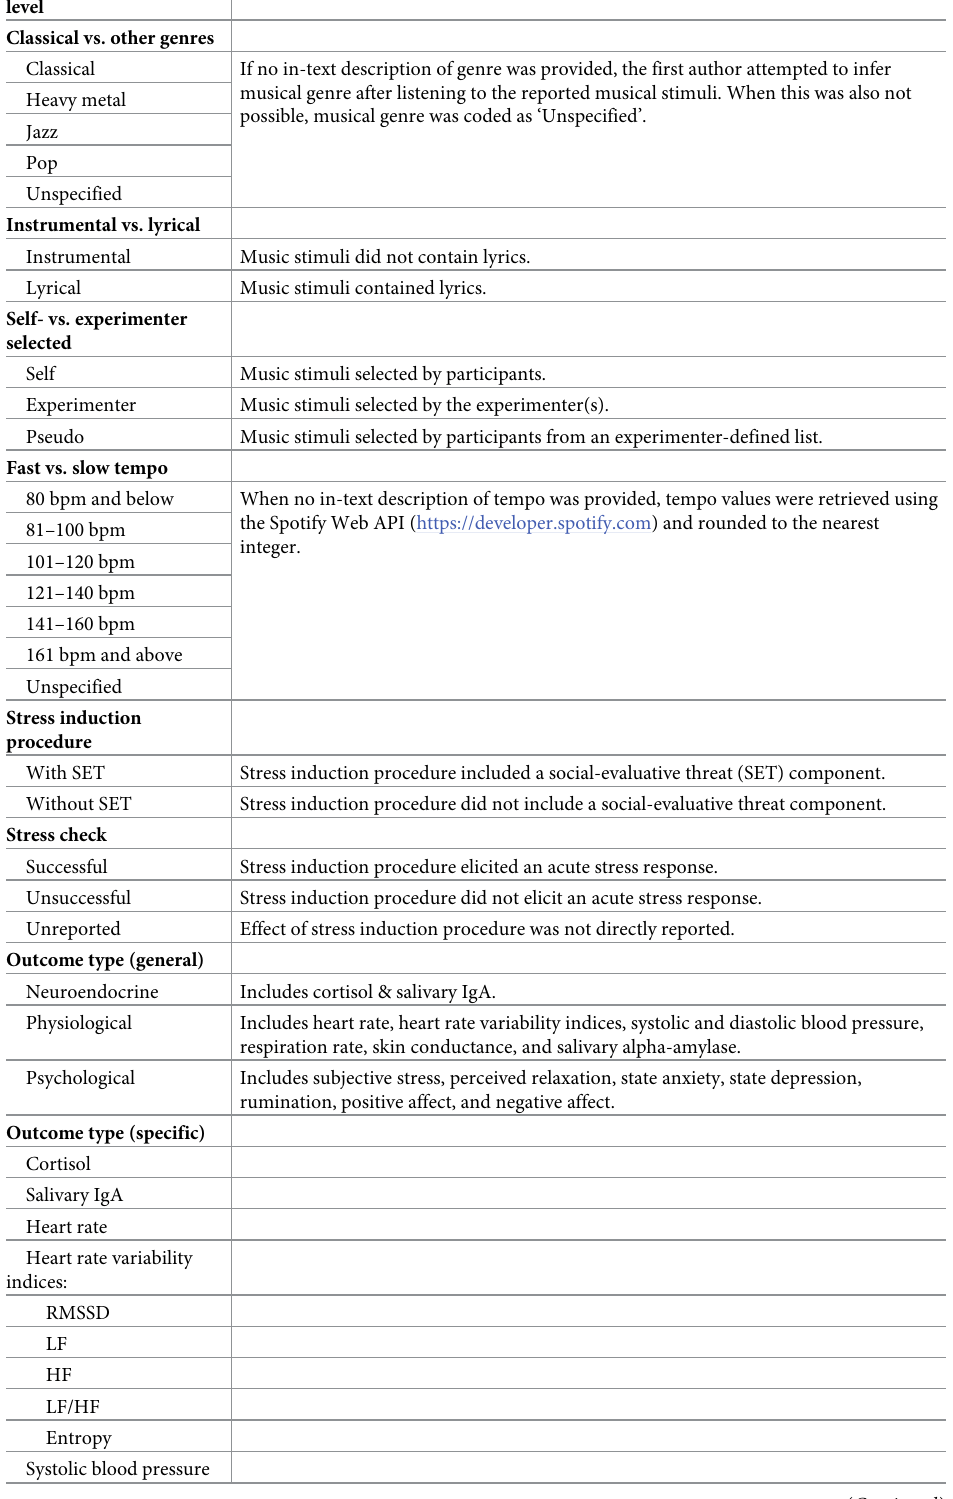
Table 1. Moderator coding